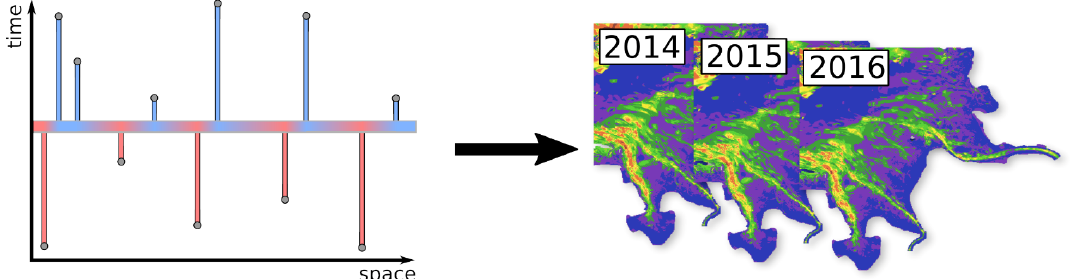
Figure 6. Concept of spatiotemporal interpolation of surface sedimentological